Question: Condense the content of this figure into a single sentence.
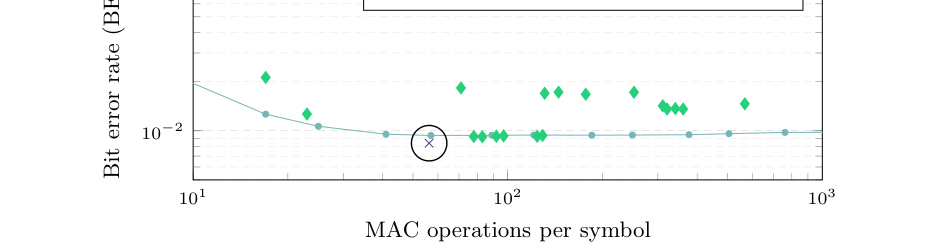
Answer: Complexity and communication performance of the selected model as com- pared to conventional FIR ﬁlters and Volterra kernels for the magnetic recording channel